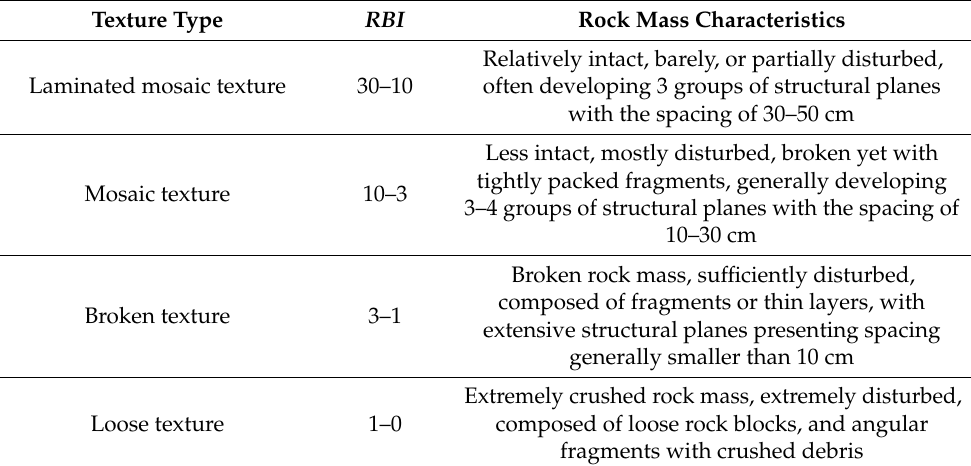
Table 2. Representation of rock mass textures by RBI